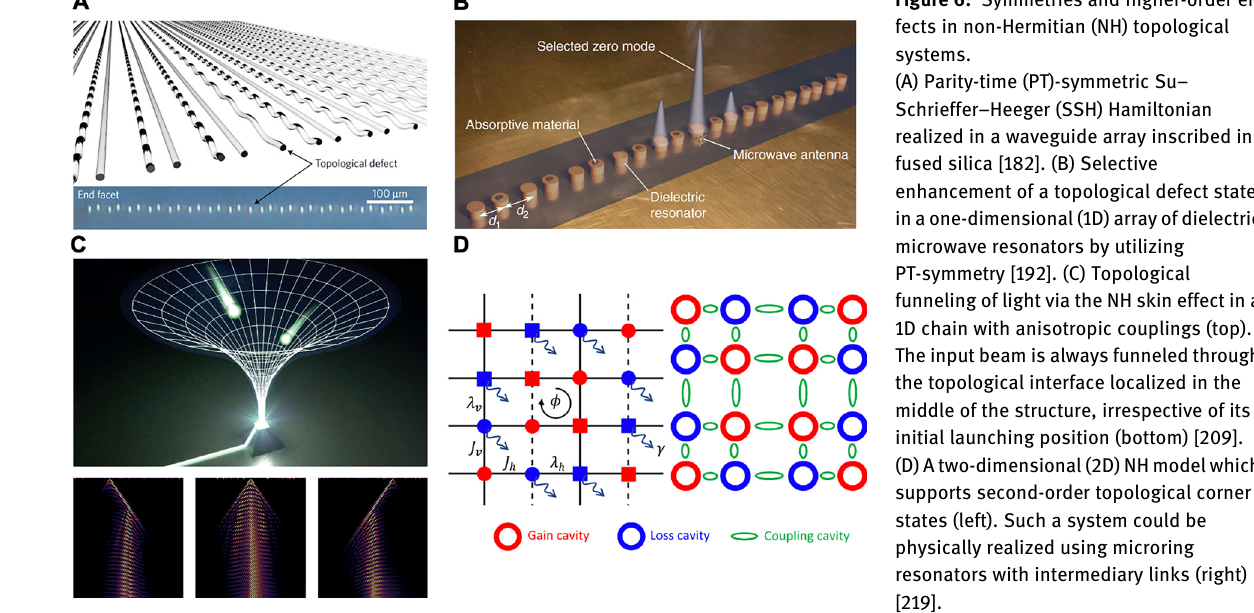
Figure 6: Symmetries and higher-order ef- fects in non-Hermitian (NH) topological